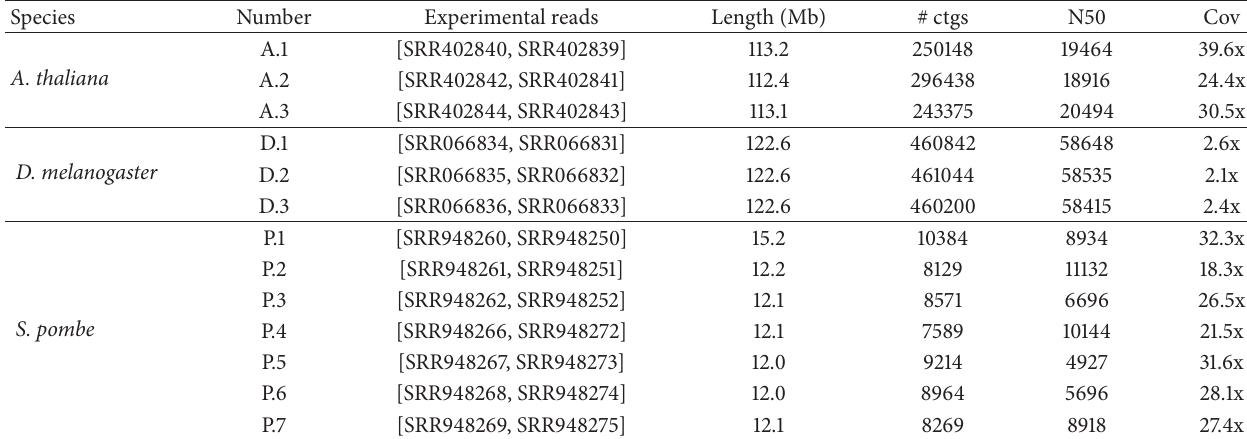
Table 2: Assembly of real experimental reads (contigs).